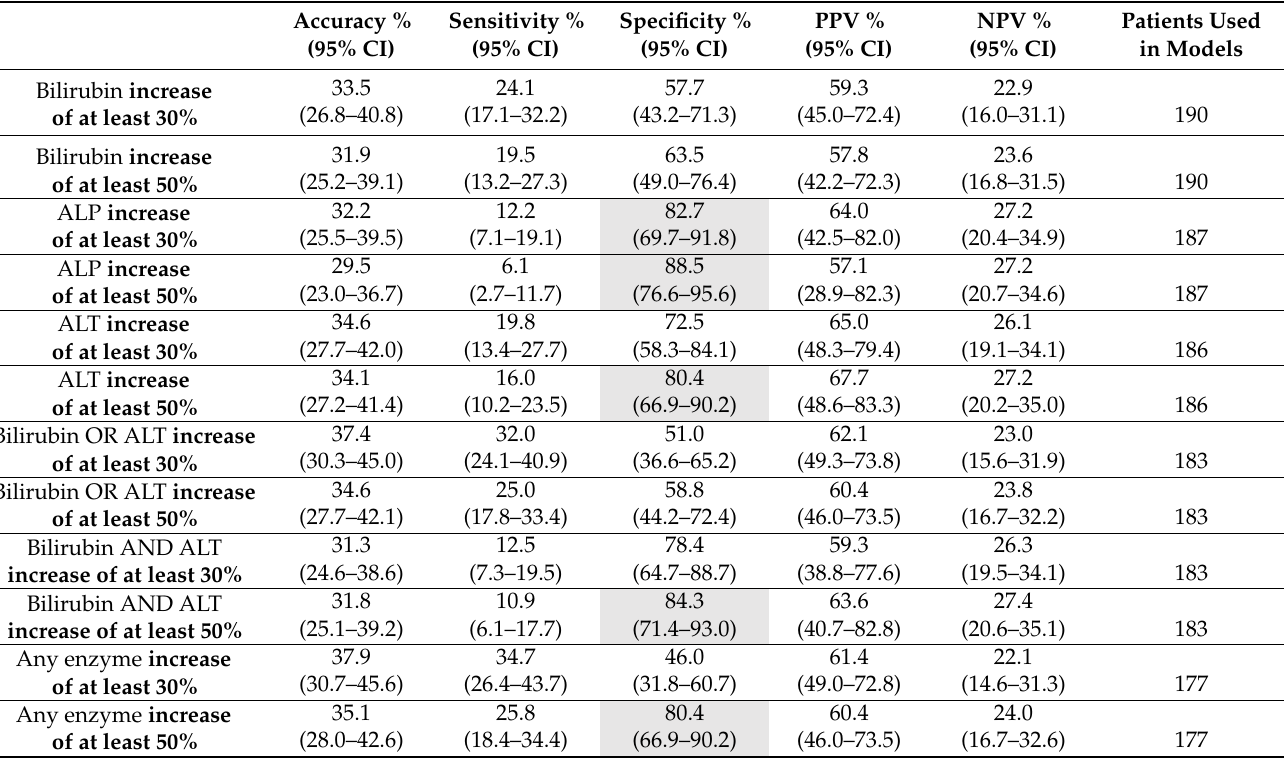
Table 3. Performance characteristics of an increase in liver enzymes within 72 h preceding ERCP or EUS as a predictor of the presence of choledocholithiasis